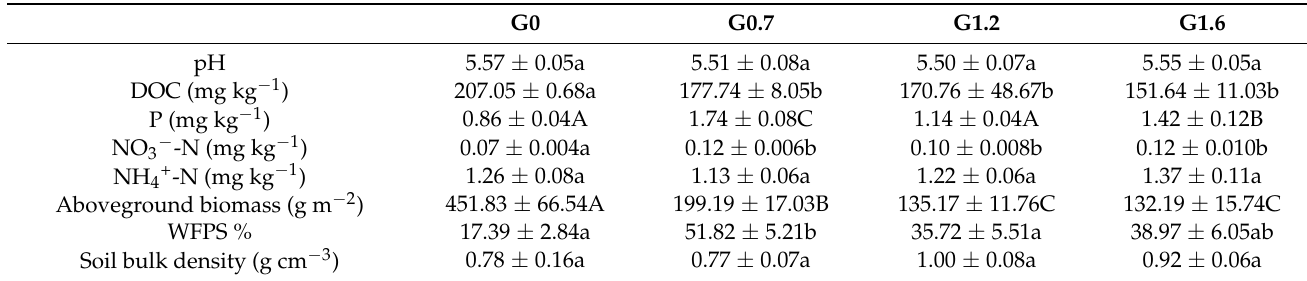
Table 1. Soil factors, pH, and AGB (aboveground biomass) in grasslands under different grazing intensities in 2013.